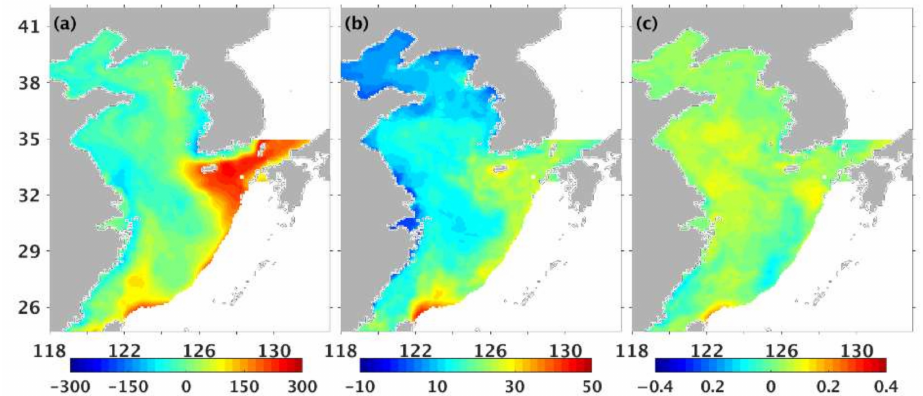
Figure 5. ( a ) Annual mean (W m − 2 ), ( b ) standard deviation (W m − 2 ), and ( c ) linear trend (W m − 2 month − 1 ) for the air-sea heat flux in the BYECS during the 1993–2019 period from the JCOPE2M reanalysis